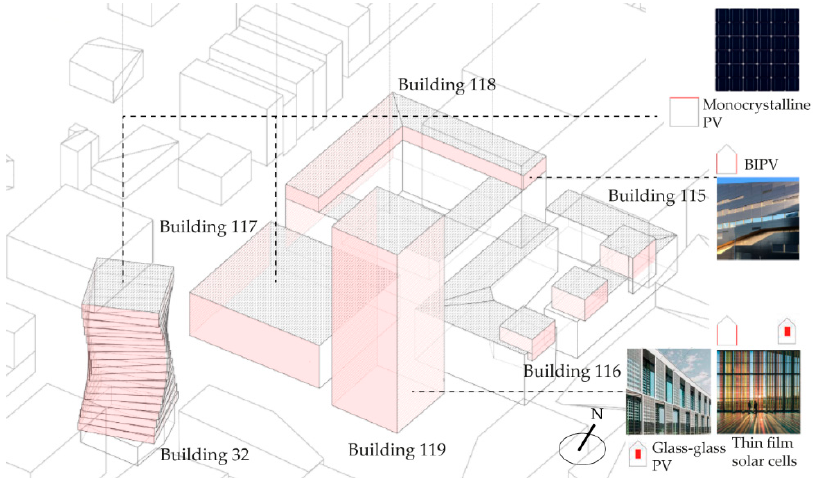
Figure 27. Solar technology recommendations for the critical area for feasibility study II.